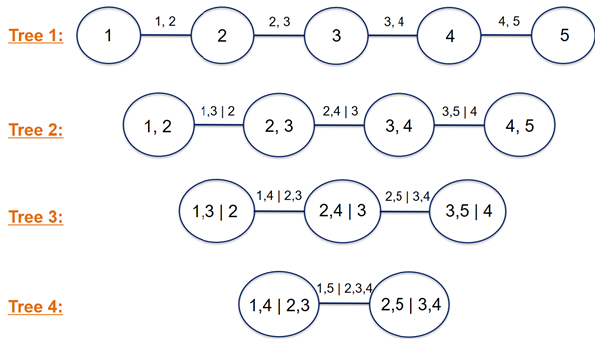
Figure 1. Example of Dvine structures with five variables, four trees, and 10